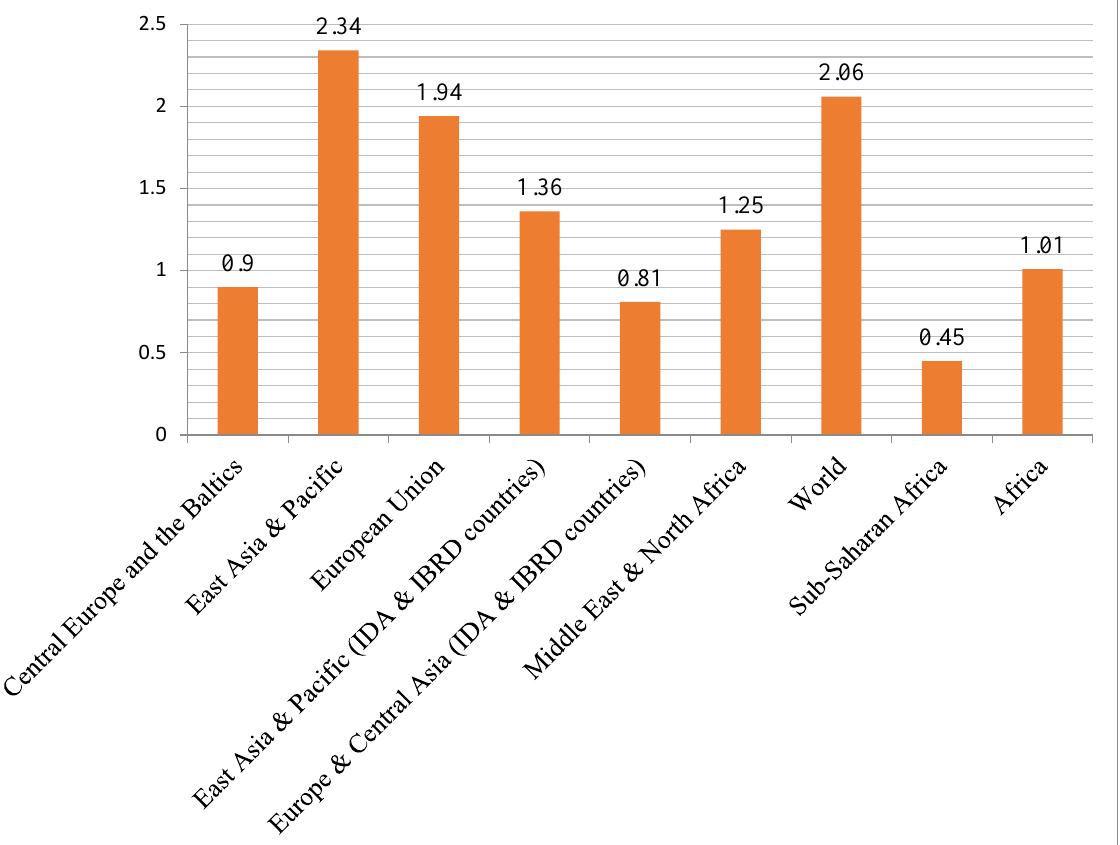
Figure 11. Research and development expenditure (% of the GDP)—Sub-Saharan Africa by countries from 1980–2021. Source: [89].